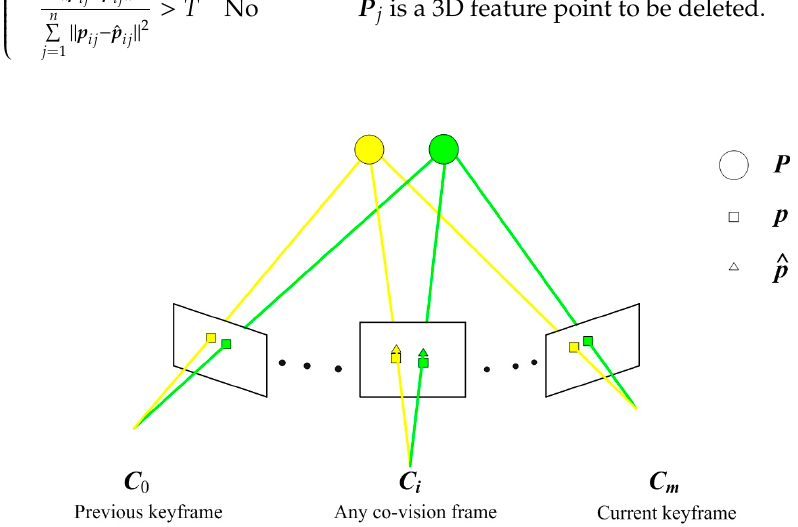
Figure 6. Schematic diagram of 3D feature points map construction.